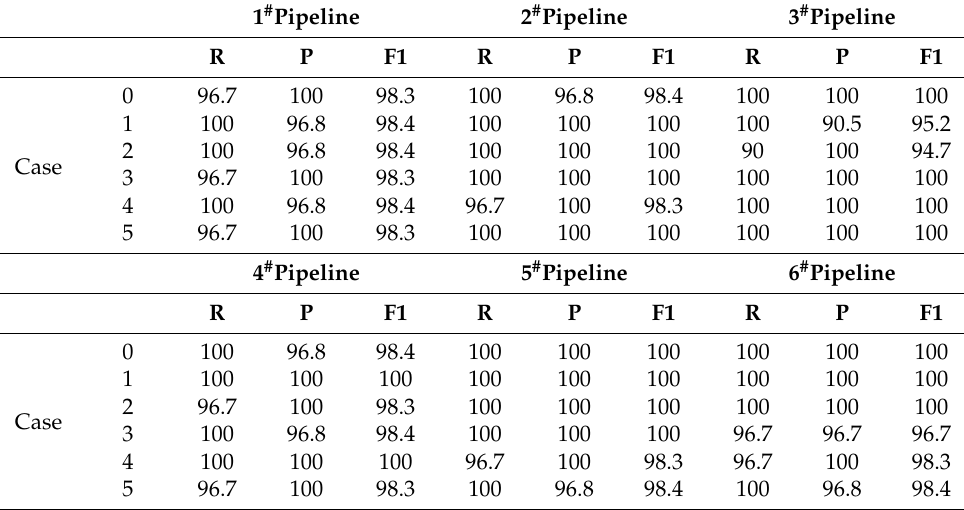
Table 7. Three common evaluation metrics results of six pipeline dimensions.